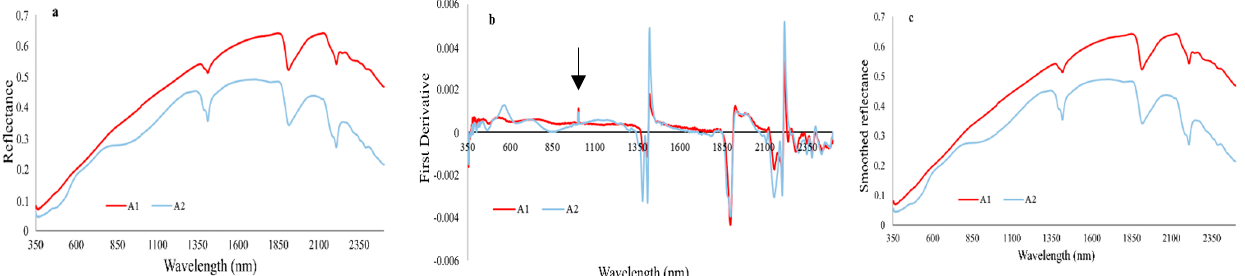
Figure 8. Treatments for the mean spectral data of the samples from A1 and A2: ( a ) untransformed Spectra; ( b ) first derivative; ( c ) Savitzky–Golay smoothing.